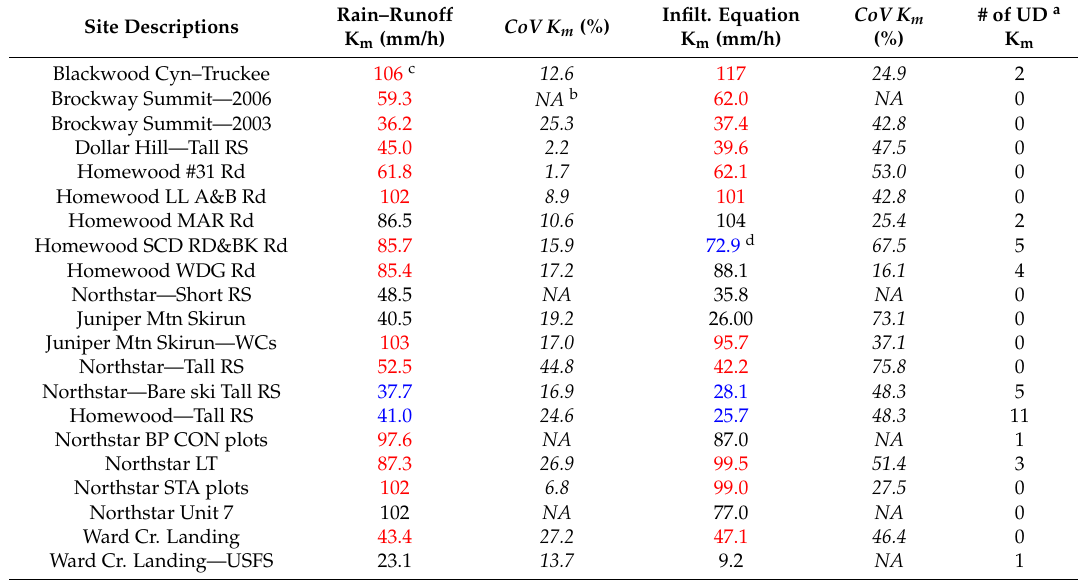
Table 10. Summary of the steady Rain–Runoff and Infiltration Equation based K m values associated with volcanic RS plots having runoff.